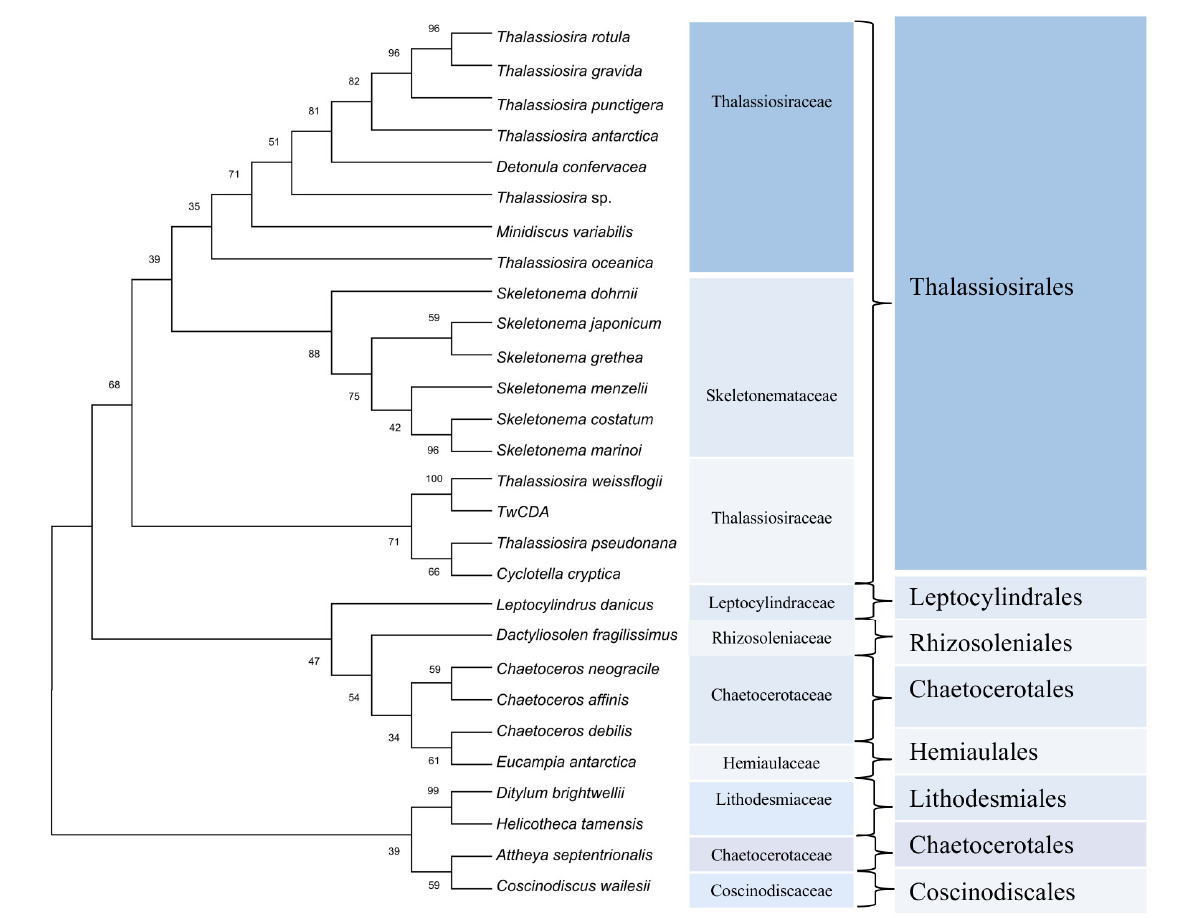
Figure 3. Phylogenetic tree constructed based on 28 putative chitin deacetylase amino acid sequences in diatoms. Proteins are from the MMETSP, PhycoCosm, and PLAZA databases. The tree was constructed using the neighbor-joining algorithm with 1000 bootstrap replicates. The number at each branch node represents a bootstrap value.